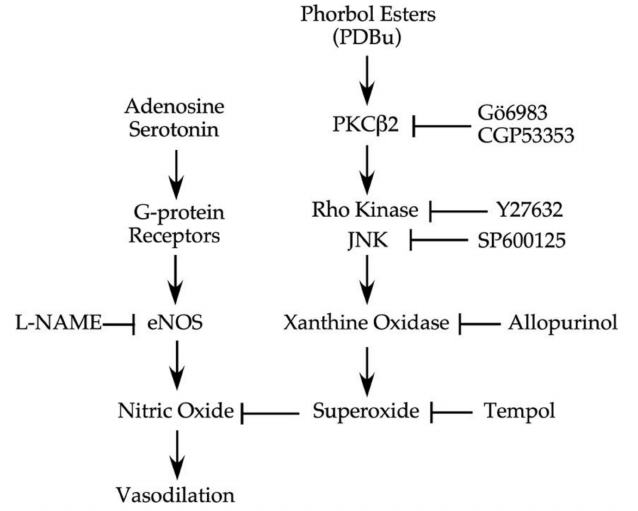
Figure 7. The diagram summarizes the pathways involved in endothelial dysfunction elicited by PDBu. Both serotonin and adenosine activate their G-protein coupled receptors and elicit endothelium-dependent nitric oxide (NO)-mediated vasodilation via endothelial NO synthase (eNOS). Activation of PKC by a nanomolar concentration of PDBu has a minimal effect on vas- cular tone but compromises NO-mediated vasodilations in response to adenosine and serotonin due to increased superoxide production. The signaling events through Rho kinase and JNK act in concert following PKC β 2 activation to promote superoxide production from xanthine oxidase and consequently lead to NO deficiency. The inhibitors used in the present study to probe the involved signaling molecules are